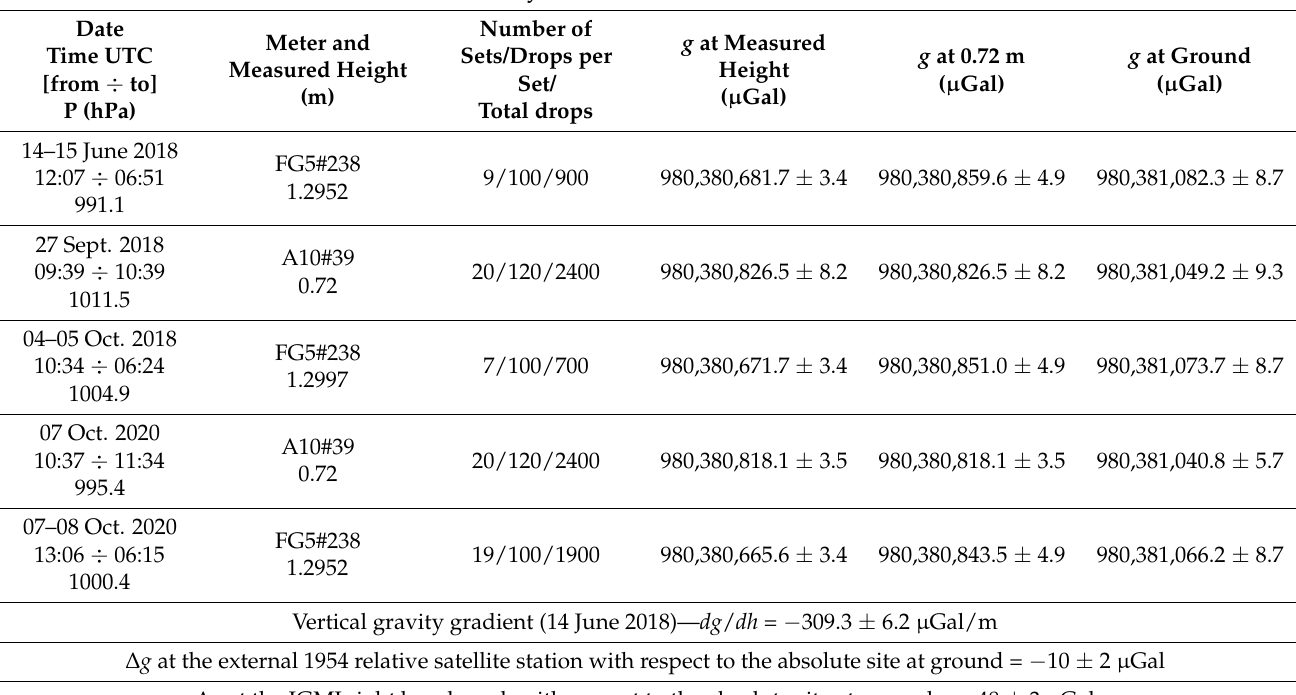
Table 8. Absolute gravity measurements collected at Terni station (TERN) during June 2018–October 2018 and October 2020 period by FG5#238 and A10#39 absolute ballistic gravimeters. The combined uncertainties δ tot associated with the g values are also